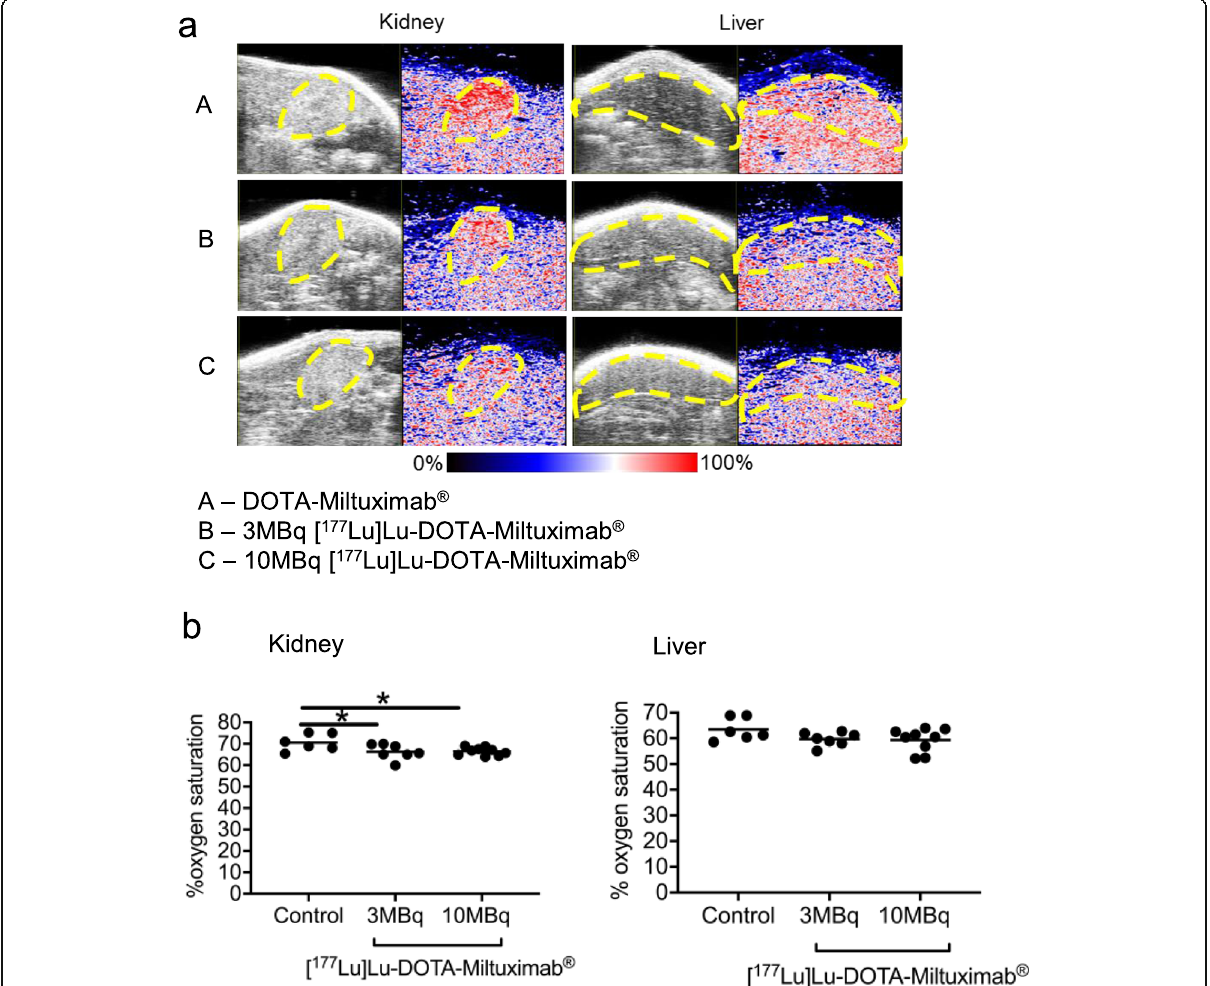
Fig. 5 Measurement of tissue oxygen saturation level in DU-145 xenografted mice treated with either DOTA-Miltuximab®, 3 MBq [ 177 Lu]Lu-DOTA- Miltuximab® or 6 MBq [ 177 Lu]Lu-DOTA-Miltuximab®. Photoacoustic imaging for oxygen saturation of haemoglobin in kidney and liver was performed on days 30 to 35 post Lu injection. a Representative images showing oxygen saturation levels in kidney and liver. b Quantitation of oxygen saturation in kidney and liver. Data are expressed as % oxygen saturation level, means are indicated by horizontal lines, and statistical analysis was performed using Dunnett ’ s multiple comparisons test. * p <